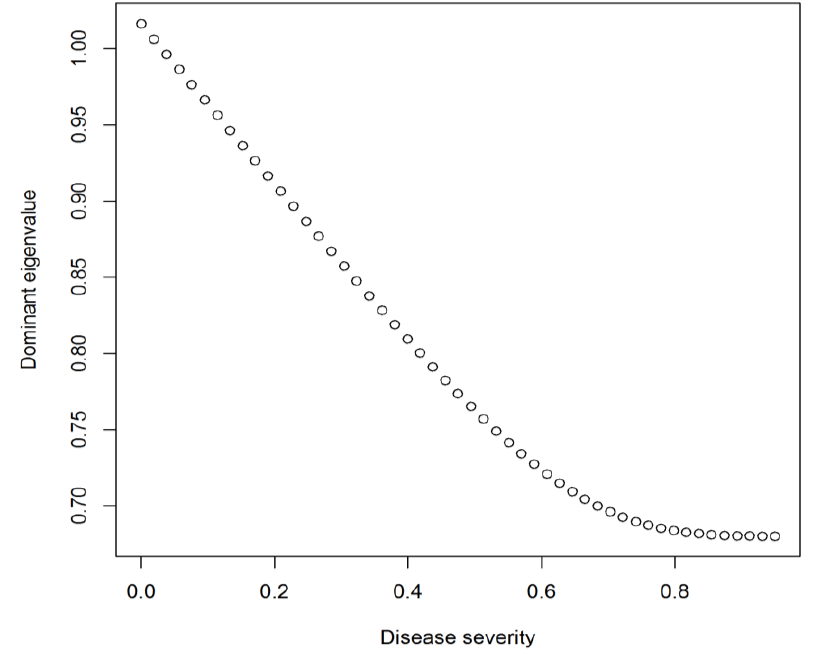
Figure 2. Dominant eigenvalues from a demographic matrix projection model of Monterey pine populations plotted against hypothetical disease severity levels for pitch canker where disease severity is defined as the proportion of infected susceptible tissue.